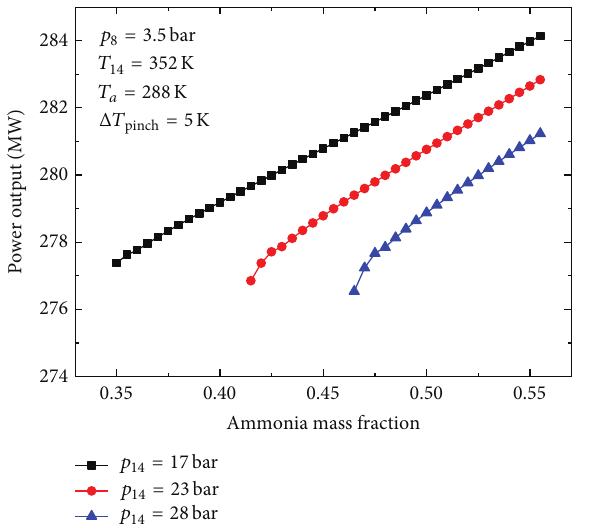
Figure 16: Variation of LEC of combined cycle with ammonia mass